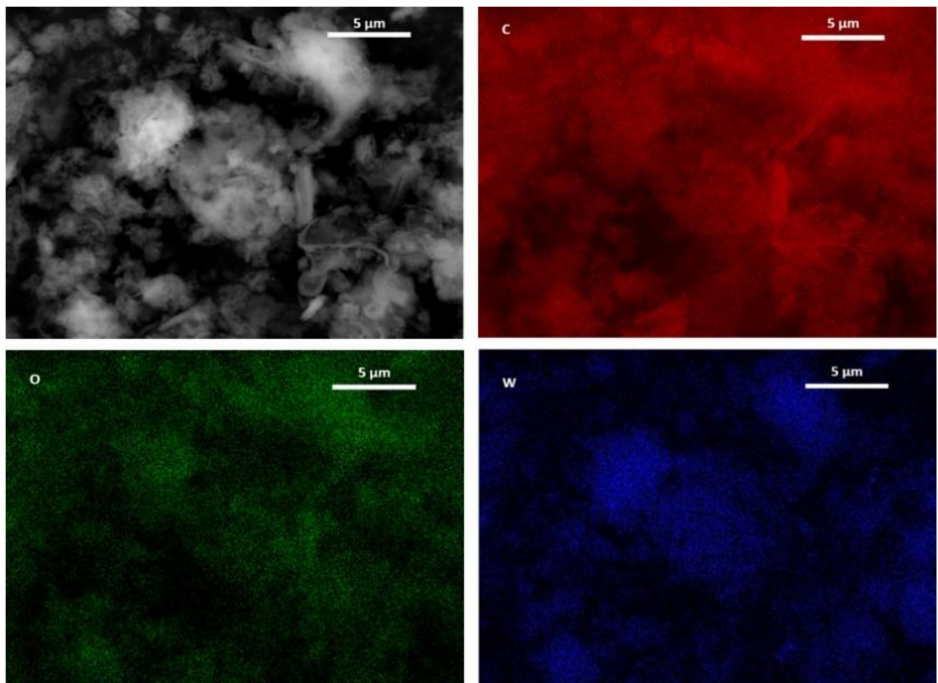
Figure 6. SEM and EDX elemental mapping images of GF_ND8_Co4 at 10,000 × g